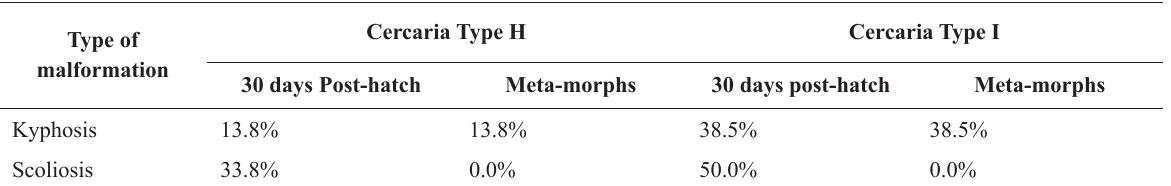
Table 3: Percentages of malformations in P. cruciger exposed to cercariae types H and I at 30 days post-hatch stage and at metamorphosis (exposure at Gosner stage 27/28).